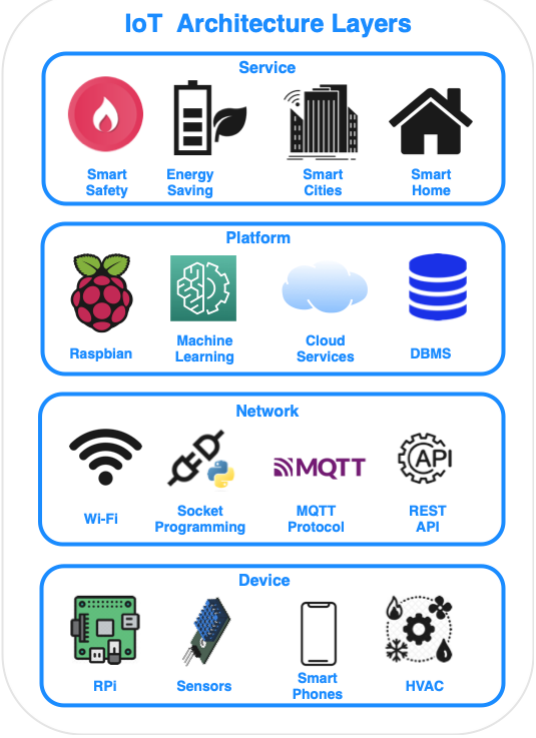
Figure 1. The four layers of IoT